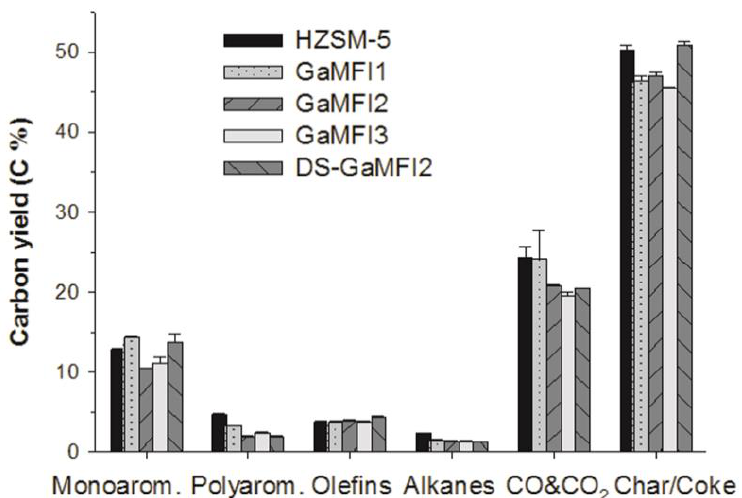
Figure 3. Carbon yields of major products in CFP of beech wood with HZSM-5 and Ga-containing MFI zeolites.